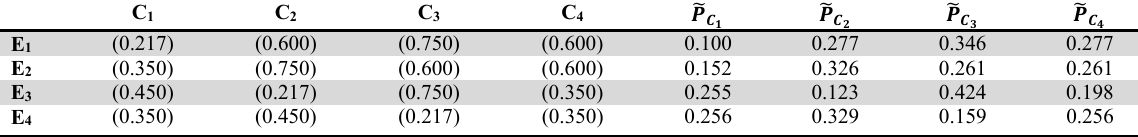
Crisp values and criterion projection value